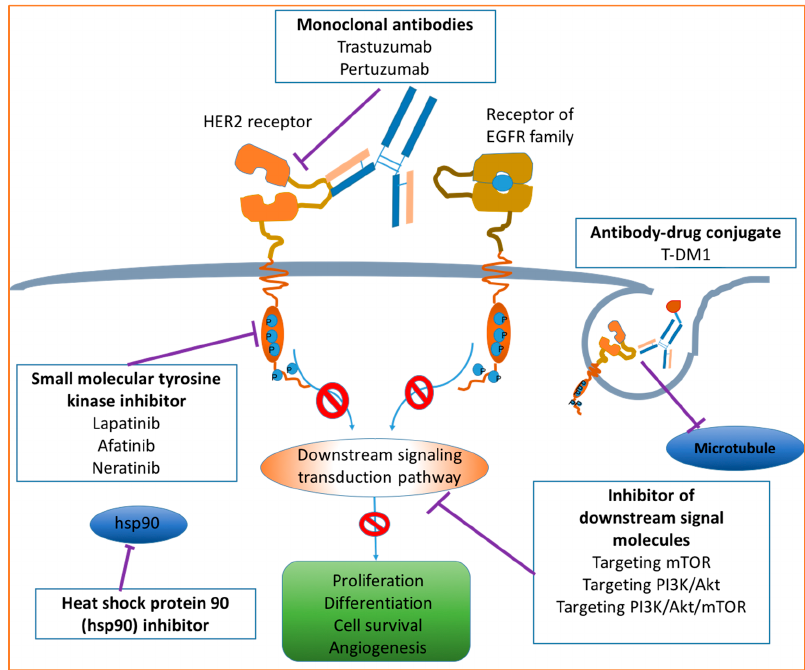
Figure 4. Molecular approaches for HER2+ BC therapy. Modified from the work contributed by Tsang [13]. Drugs targeting HER2 may include monoclonal antibodies, small molecular tyrosine kinase inhibitors, antibody–drug conjugates, heat shock protein 90 inhibitors and inhibitors of downstream signal molecules. T-DM1: